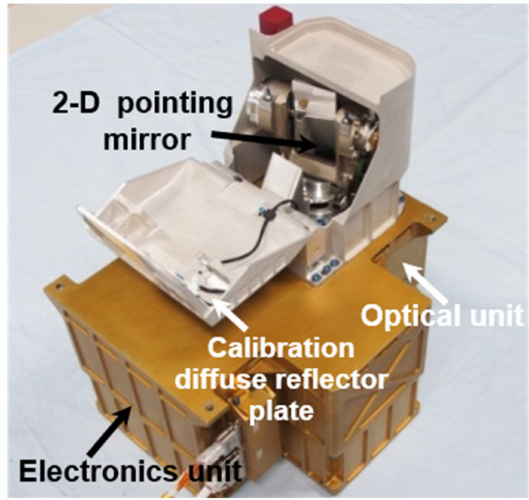
Figure 2. The composition of LMS.